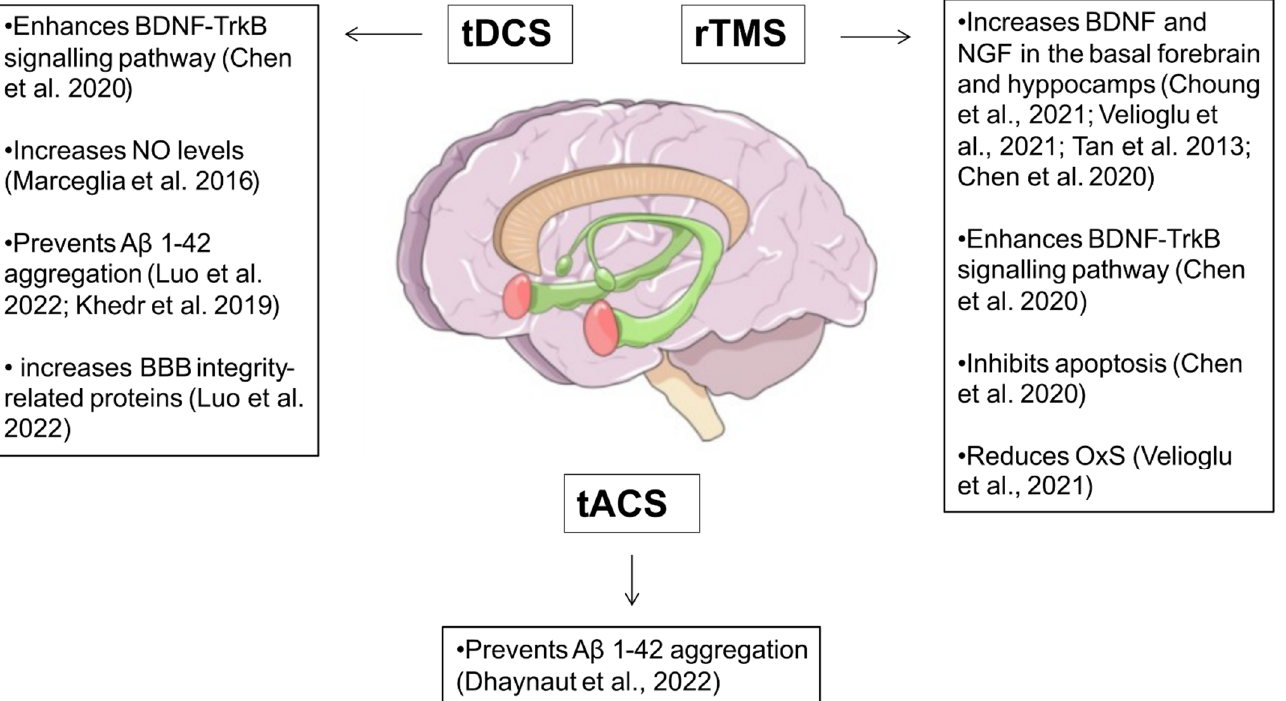
Figure 2. Schematic overview of neuroprotective effects of NIBS in Alzheimer’s disease. tDCS = transcranial direct current stimulation; tACS = transcranial alternating current stimulation; rTMS = repetitive transcranial magnetic stimulation; BDNF = brain-derived neurotrophic factor; TrkB = Tropomyosin receptor kinase B; NGF = Nerve growth factor; NO = nitric oxide; OxS = oxidative stress. Choung et al., 2021 [70]; Velioglu et al., 2021 [71]; Tan et al. 2013 [73]; Chen et al. 2020 [74]; Marceglia et al. 2016 [83]; Luo et al. 2022 [88]; Khedr et al. 2019 [90]. Table 2. Studies assessing neuroprotective effects of NIBS in animal models of Alzheimer’s Disease (AD).